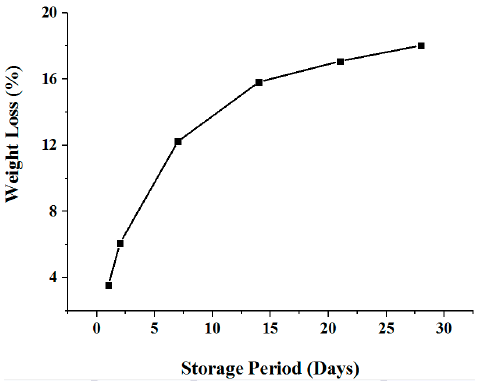
Figure 8. Weight loss of samples during storage period with respect to their fresh (0D) weight.